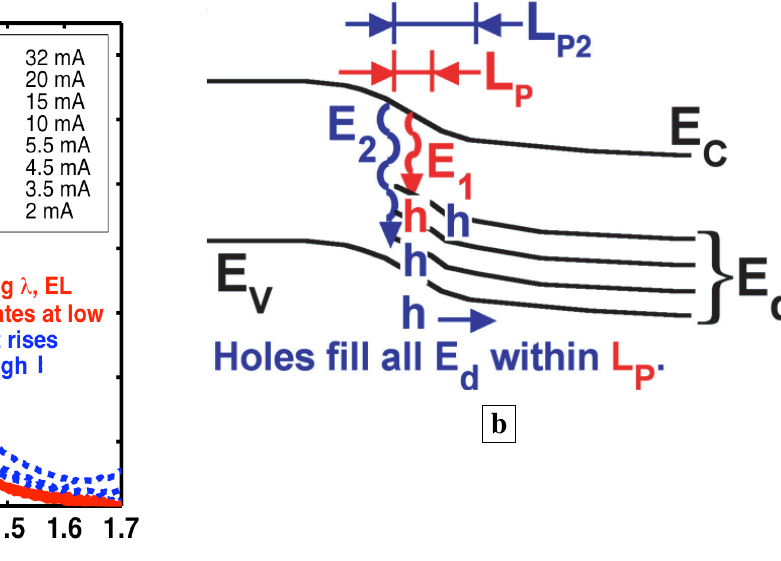
of the p-n junction P